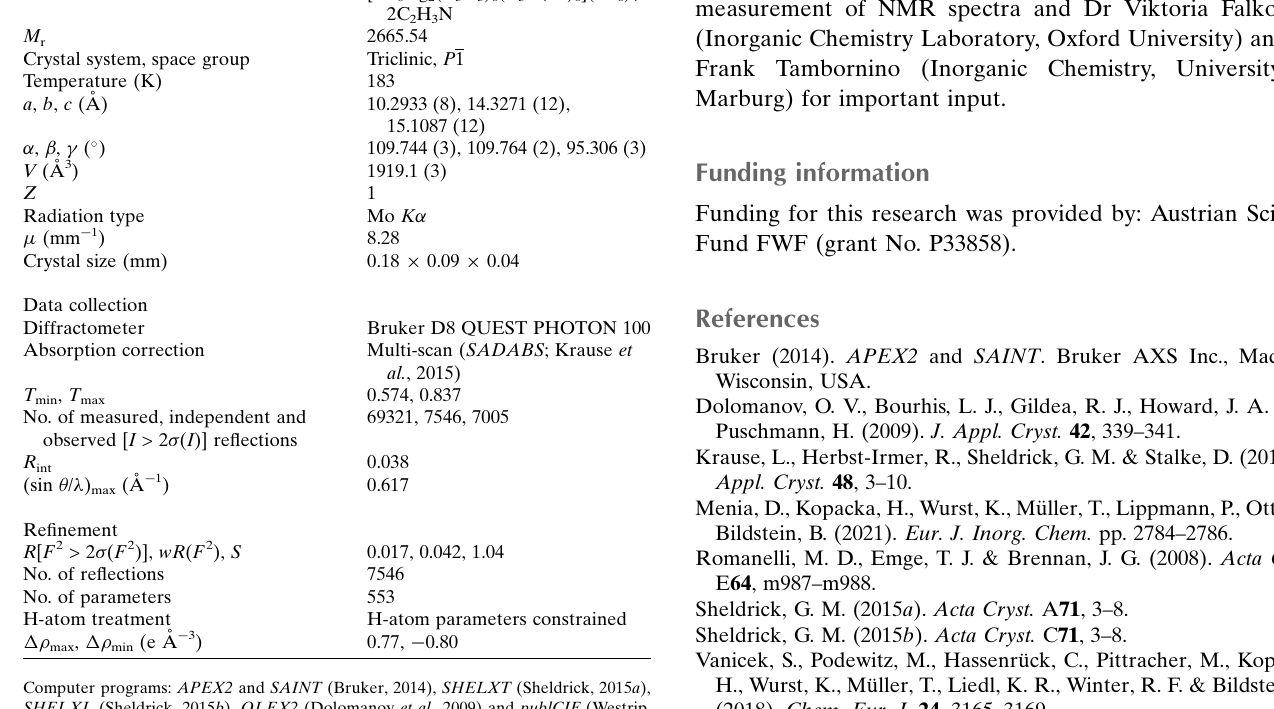
Table 1 Experimental details. Crystal data Chemical